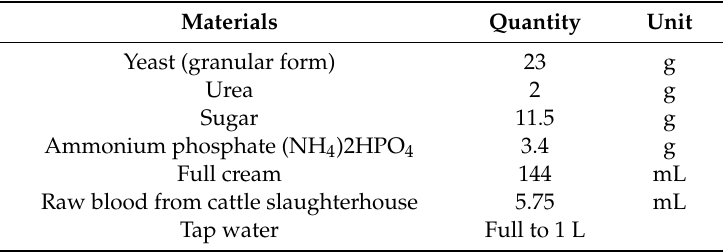
Table 2. Synthetic wastewater composition.